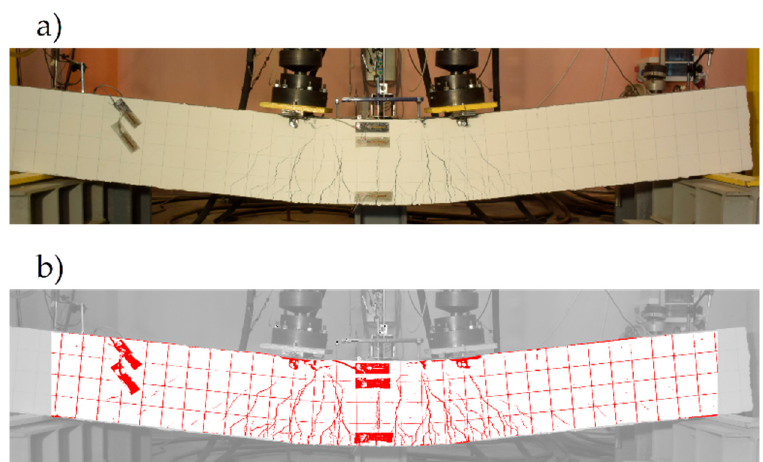
Figure 19. Illustration of the results of the algorithm used in the photogrammetric analysis: ( a ) a photo of cracked surface of beam #1; ( b ) an image of the beam after processing the photo with a visible map of the cracks. The areas representing the undamaged surface of the beam were marked in white, and the areas statistically deviating from the undamaged surface were marked in red.